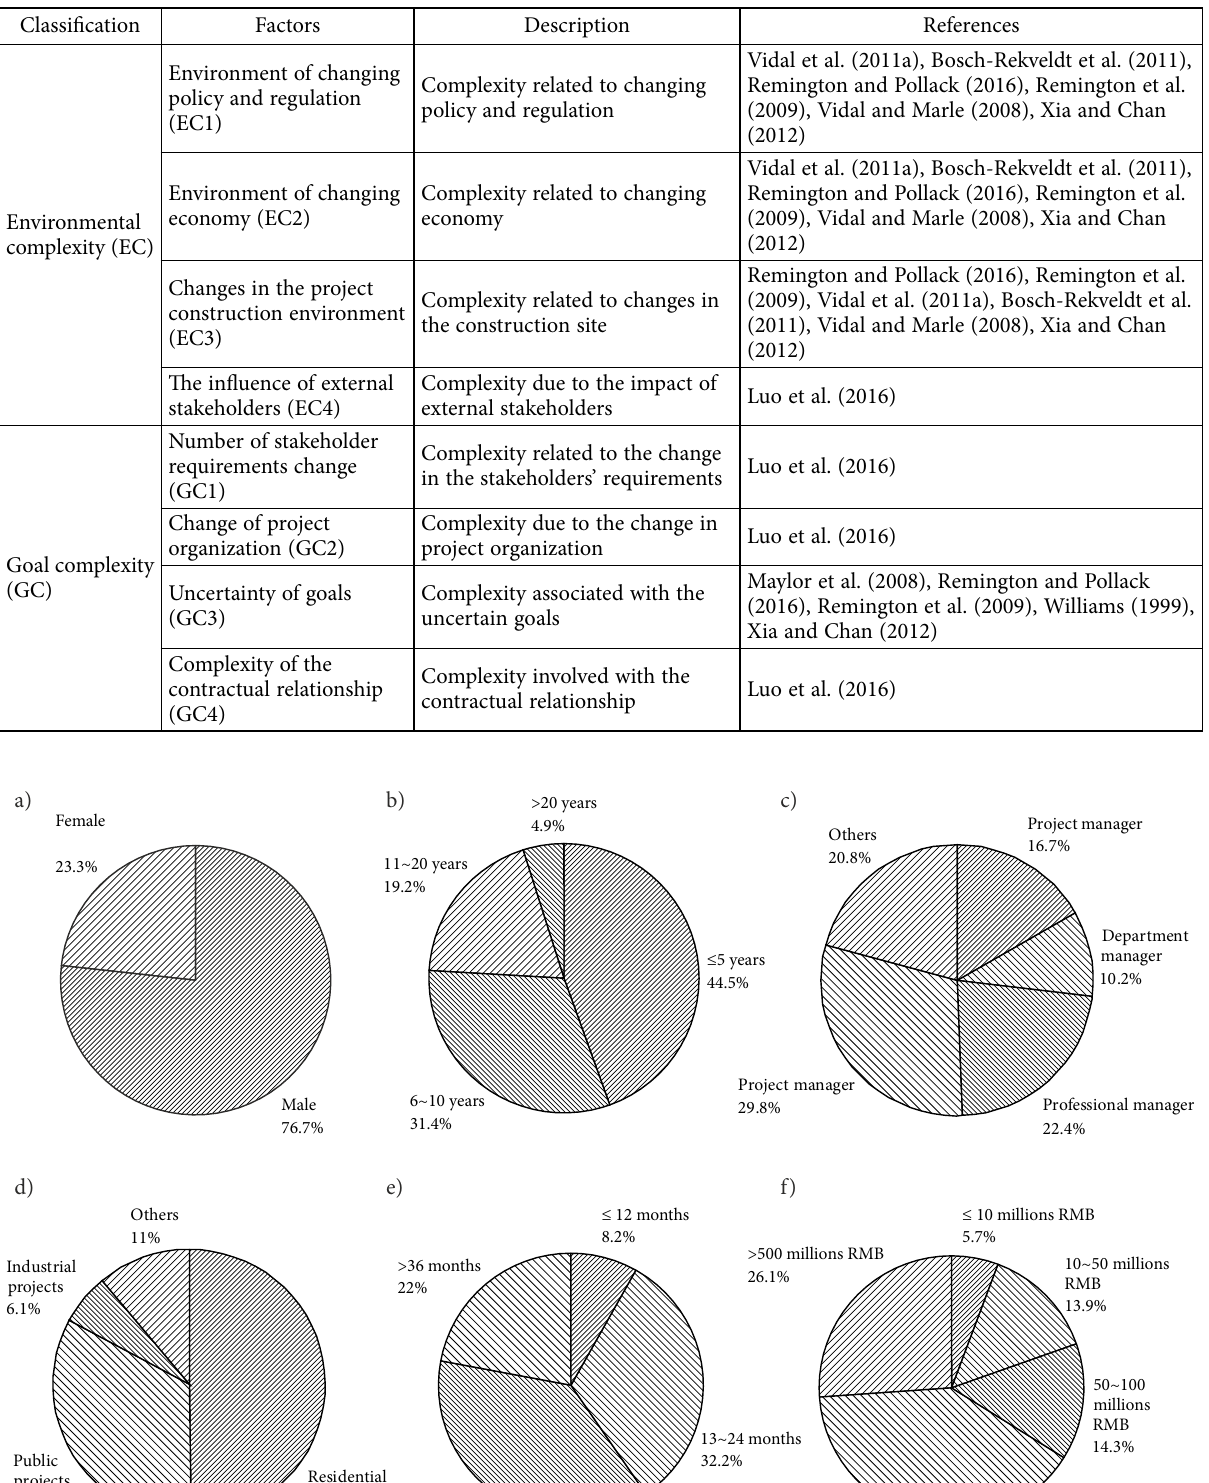
>500 millions RMB